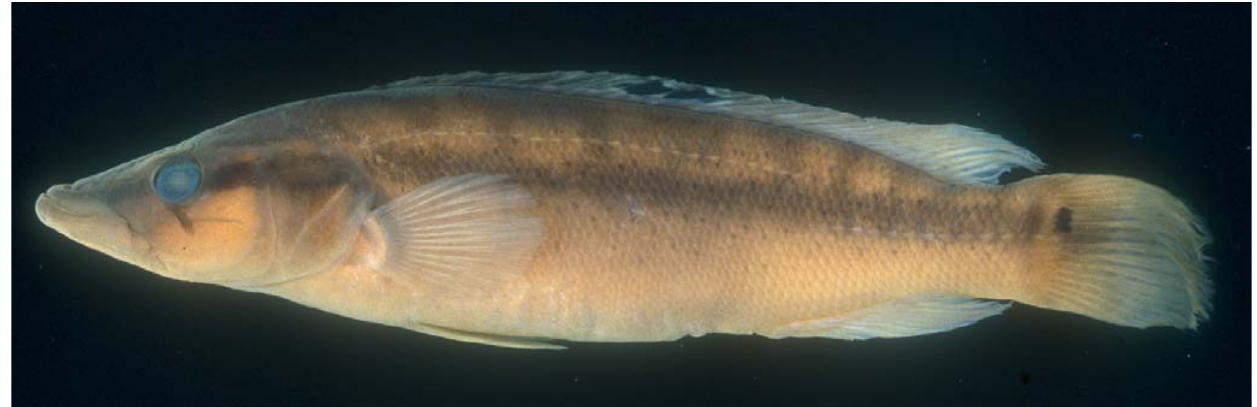
Fig. 4. Crenicichla lacustris , female, USNM 318218, 171.0 mm SL, rio Buranhem, State of Bahia,